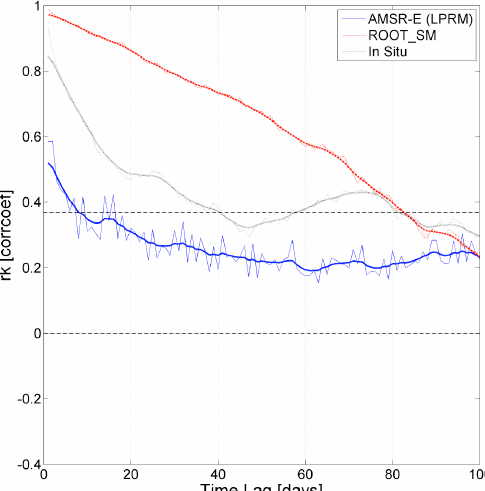
Fig. 6. Characteristic lag-time of FLUXNET in situ soil moisture against characteristic lag-time of AMSR-E (blue) and ROOT SM (red). The numbers correspond to the site-numbers in Table